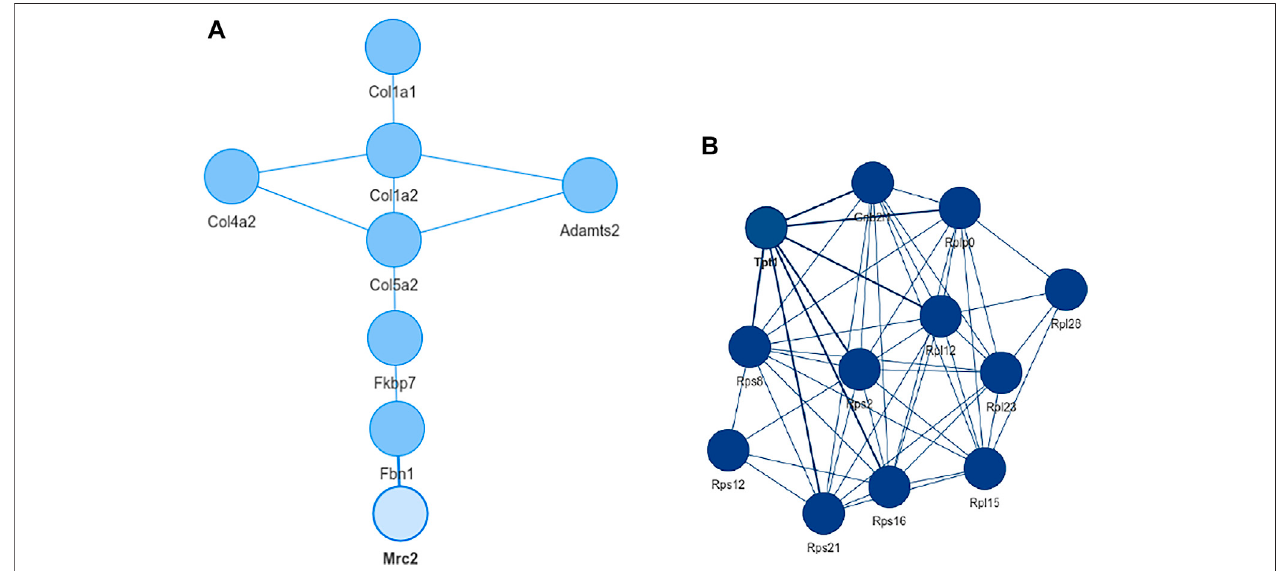
FIGURE 6 | Extracted networks from single cell data of murina limb muscle. (A) Network with the con fi guration L (cid:1) 0 and K (cid:1) 0 based on mesenchymal stem cells from the limb muscle. The genesconsist mainly ofextracellular matrix proteins and are differentially expressed in all old mice. (B) Network ofmesenchymal satellite stem cells with K (cid:1) 0 and L (cid:1) 4. With the exception Tpt1 and Gnbl2l1, all nodes are ribosomal